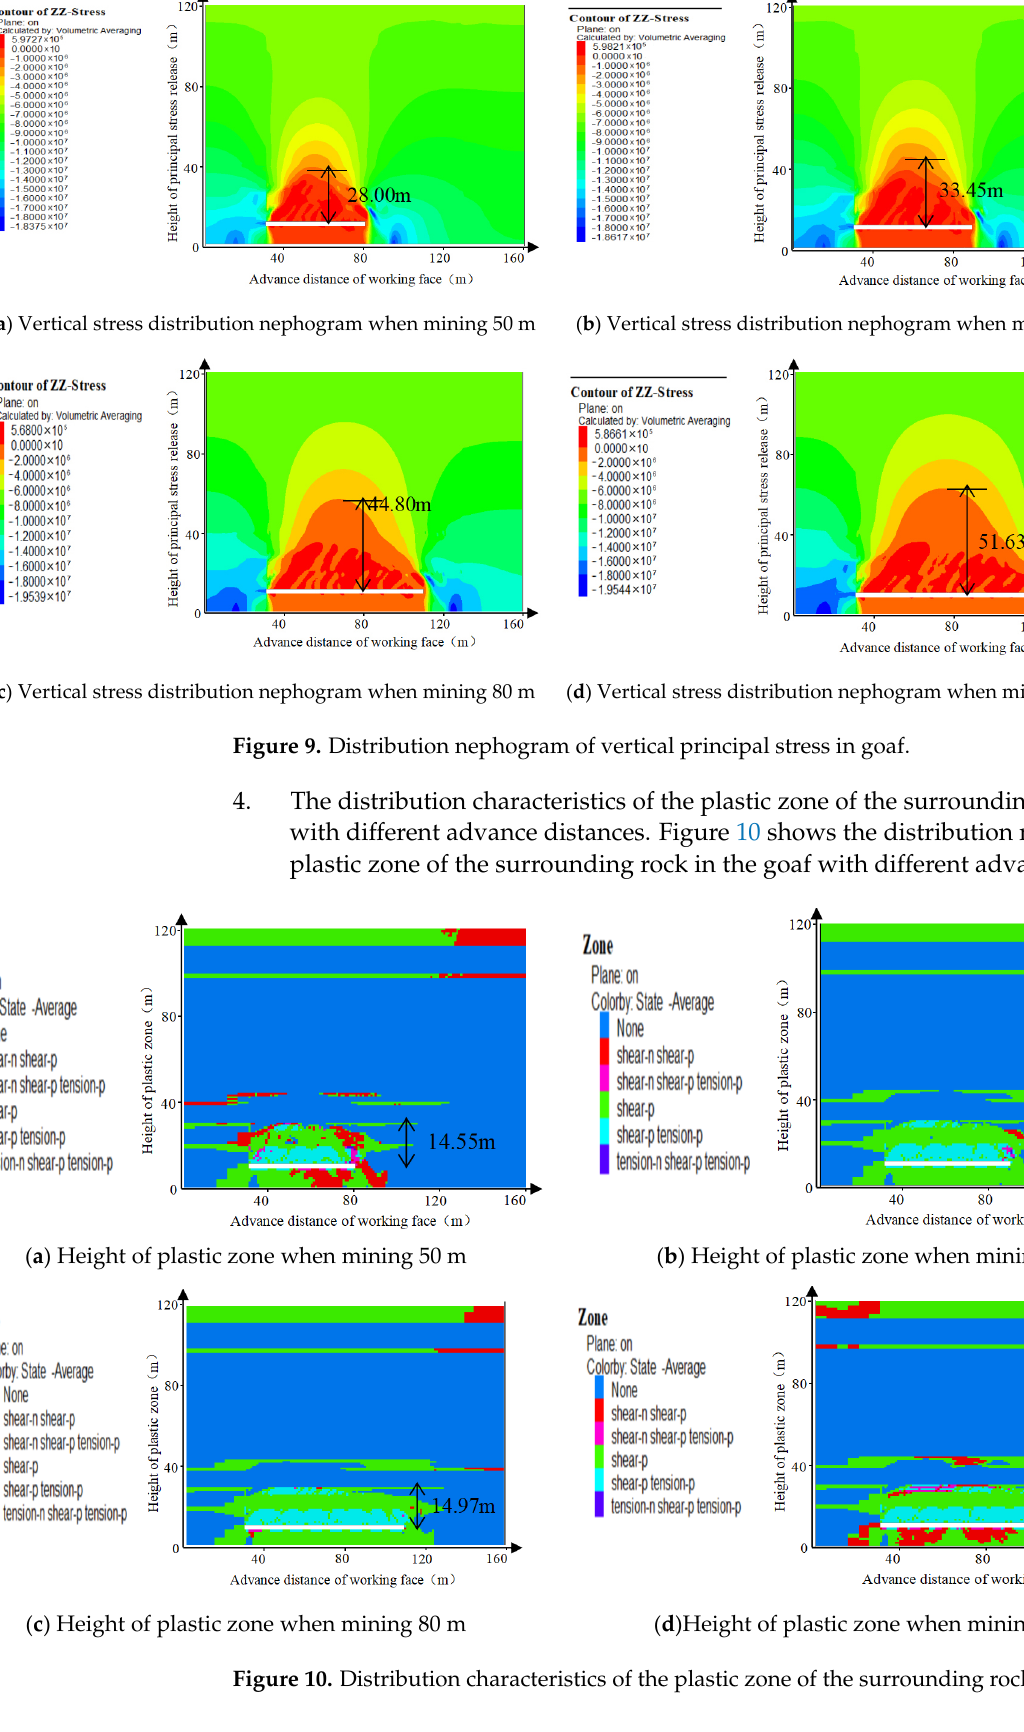
Figure 10. Distribution characteristics of the plastic zone of the surrounding rock in the